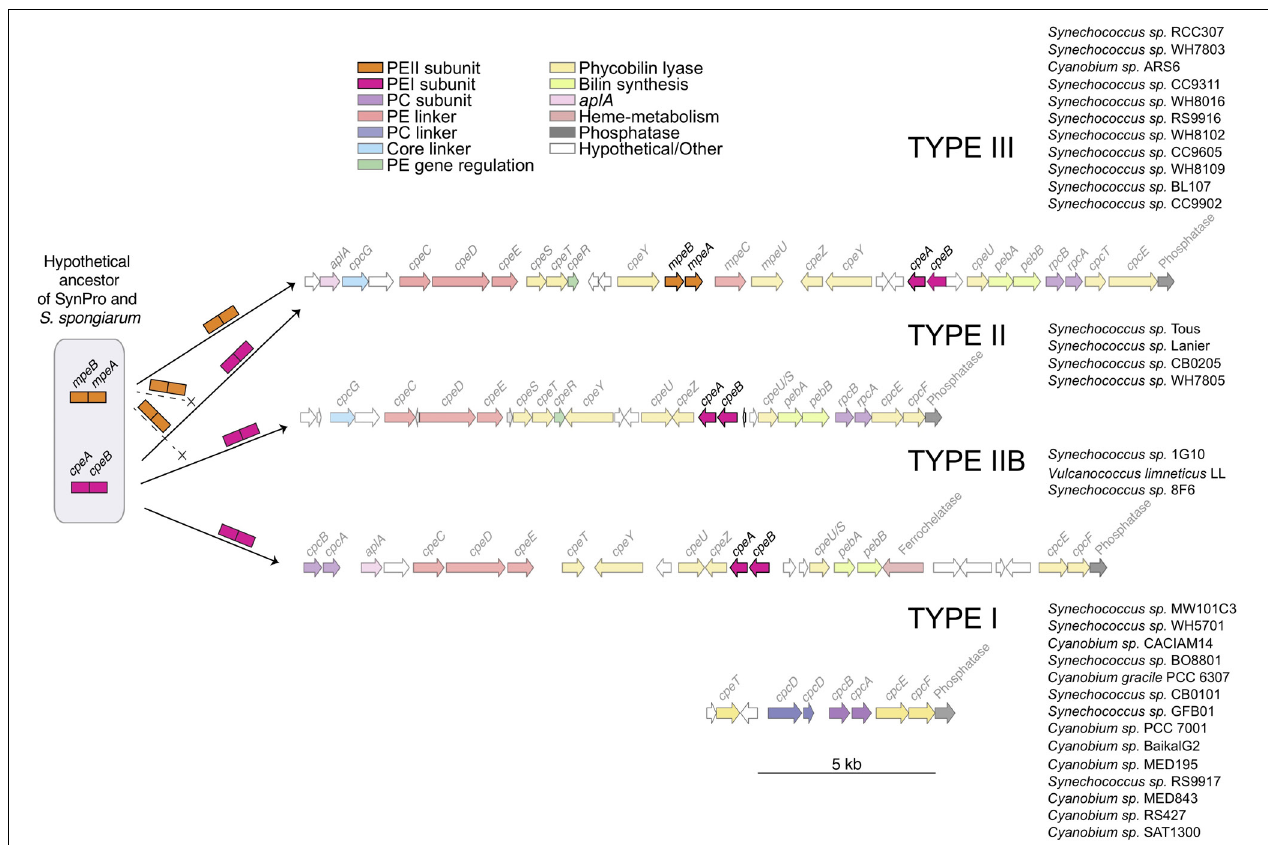
FIGURE 5 | A schematic diagram showing a hypothetical ancestor of the S. spongiarum and the Syn/Pro clade, distribution of cpeBA and mpeBA, and spatial distribution of PBS genes. The potential distribution of cpeBA and mpeBA was inferred by phylogenetic analyses shown in Figure 2 and comparative genomic analyses shown in Figure 4 and described in the text.